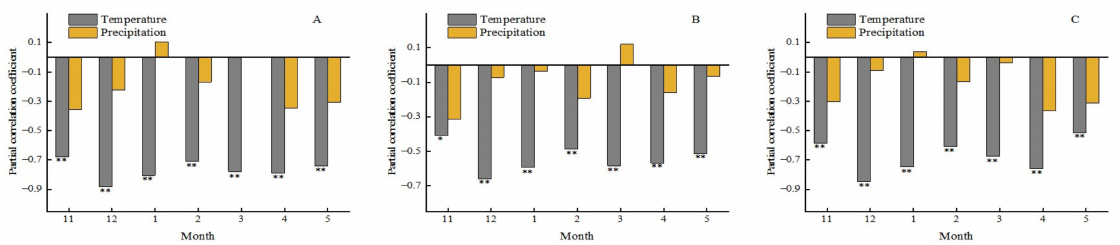
Figure 23. Partial correlation coefficient between the SOS of different forest types and temperature and precipitation. ( A ) Broadleaf Forest, ( B ) Coniferous Forest, ( C ) Mixed Forest. Note: * p < 0.05, ** p <